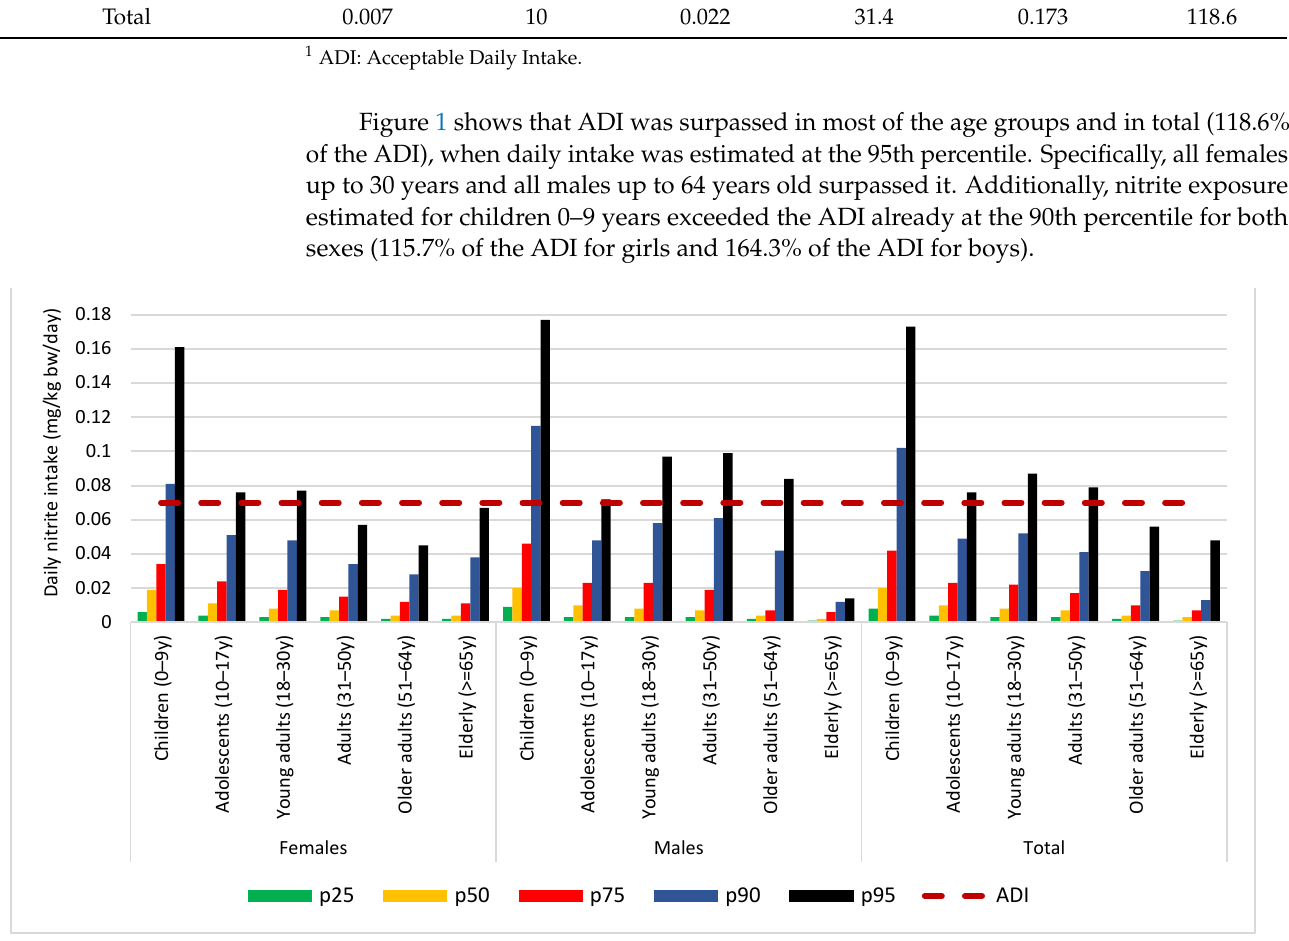
Figure 1. Distribution of daily total nitrite intake (mg/kg bw/day) by sex and age group, in comparison to ADI of 0.07 mg/kg bw/day for nitrite.